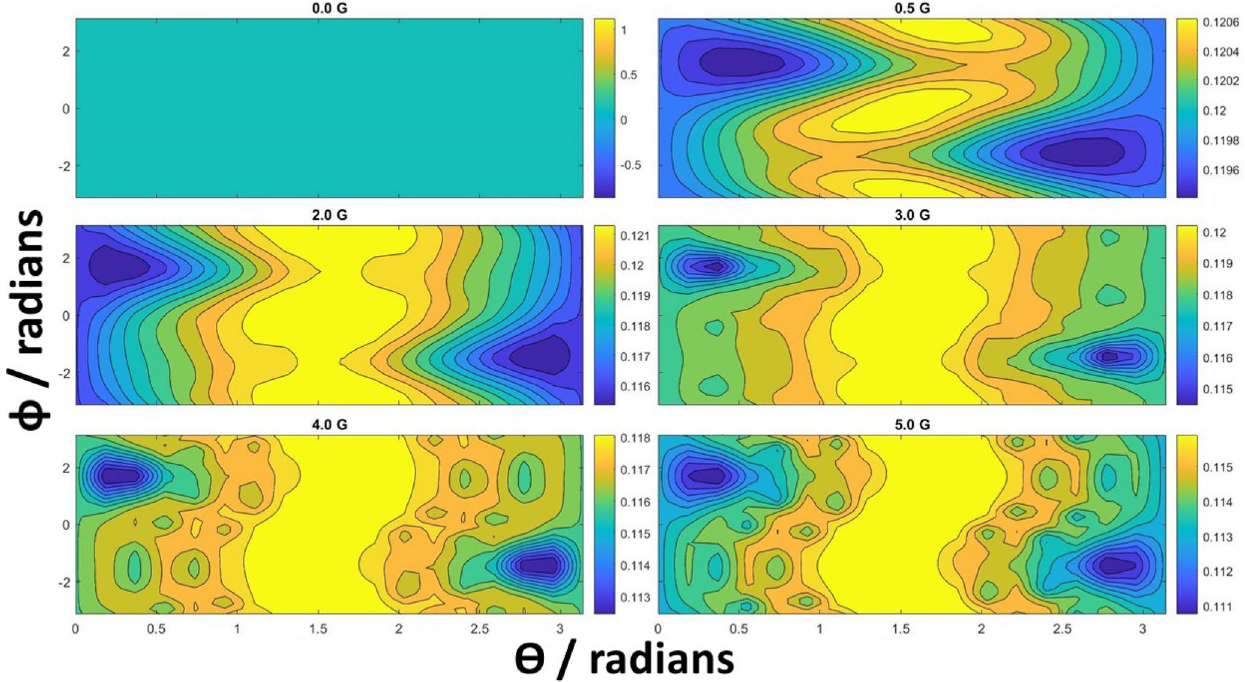
Figure 6. Signalling yield as a function of external magnetic field in the radical pair model with closed dynamics, i.e. with additional dashed magenta arrows in Fig. 4. Evolution under the magnetic field is governed by the Hamiltonian given in Eq. (3). In this particular plot, we have set k ex = 5 × 10 6 Hz and k (cid:31) = 10 7 Hz. The model preserves compass features, but the yield and variations are